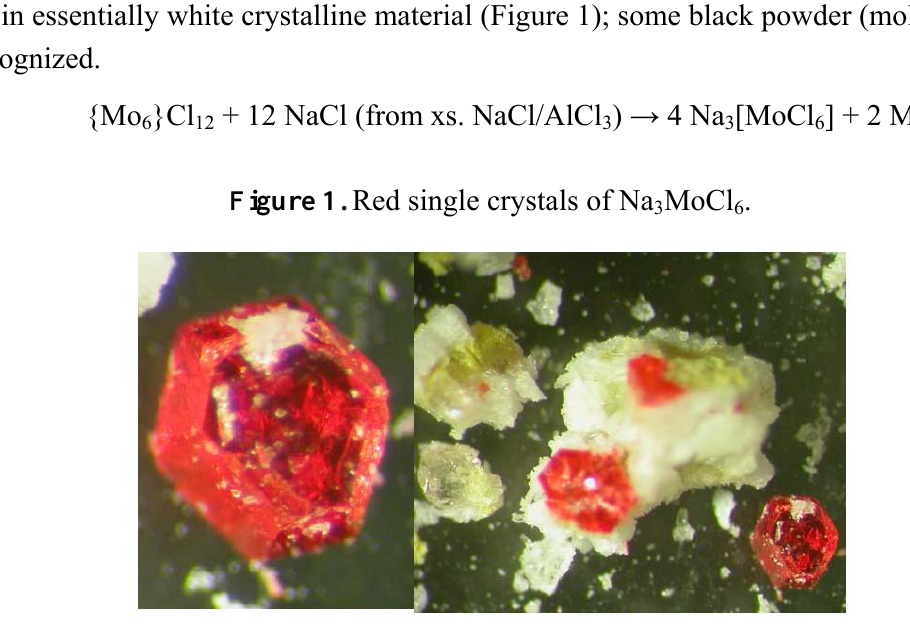
Figure 1. Red single crystals of Na